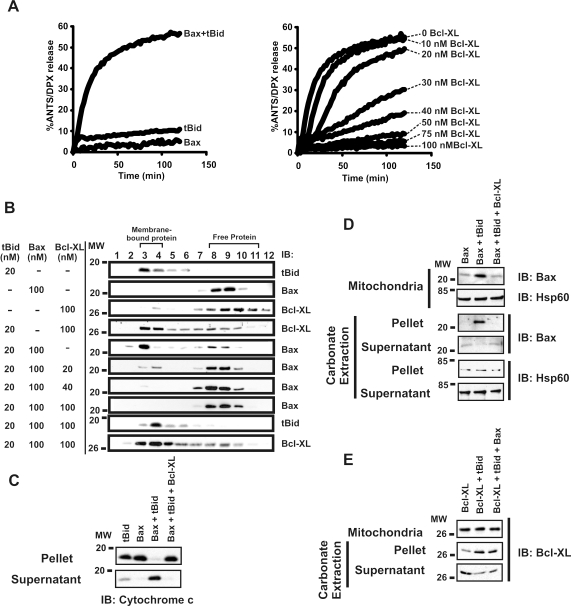
Bax and tBid Cooperate To Induce Liposome Permeabilization, Which Is Inhibited by Bcl-XL(A) Liposomes encapsulated with ANTS and DPX were incubated with 100 nM Bax, 20 nM tBid, or both (left panel) or with 100 nM Bax, 20 nM tBid, and the indicated concentrations of Bcl-XL (right panel). Membrane permeabilization was assayed by an increase of ANTS fluorescence.(B) Liposome binding of tBid, Bax, and Bcl-XL. The proteins, at the indicated concentrations, were incubated with liposomes. Membrane-bound proteins were separated from soluble proteins by Sepharose CL-2B gel filtration chromatography. Individual fractions were analyzed by immunoblotting (IB) using Bid, Bax, or Bcl-XL antibodies, as indicated.(C) Mitochondria from bak knockout mice were incubated with tBid (20 nM), Bax (100 nM), and Bcl-XL (100 nM), as indicated. Permeabilization was assayed by pelleting the mitochondria and analyzing both the pellet (P) and the supernatant (S) fractions by immunoblotting using an α-cytochrome c antibody.(D and E) Mitochondria were incubated with the indicated proteins (concentrations as in (C)) and the levels of (D) Bax or (E) Bcl-XL assayed in the mitochondrial pellet. Integration of Bax or Bcl-XL into mitochondrial membranes was assayed by carbonate extraction, using Hsp60 (a soluble matrix protein) as a control.